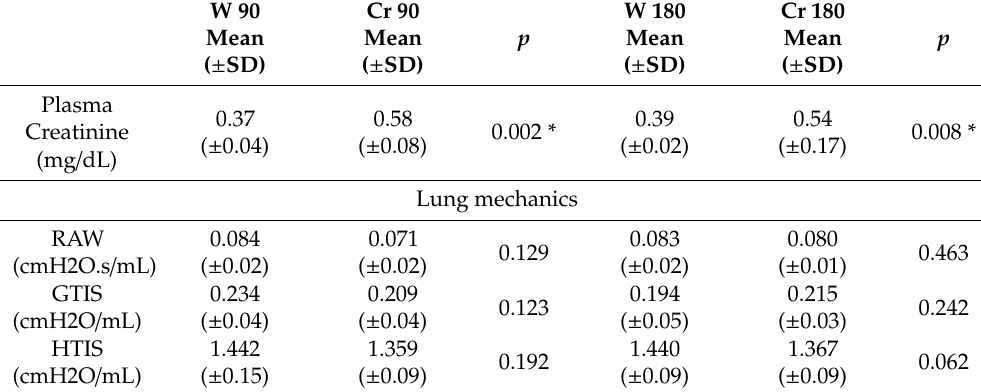
Table A1. Donors’ creatinine concentration and lung